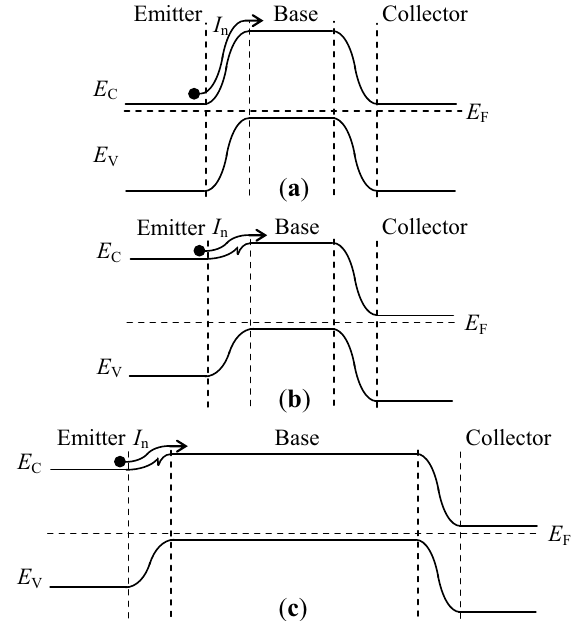
Figure 2. Transistor band diagrams: ( a ) Band diagram of the homojunction transistor; ( b ) Band diagram of the heterojunction transistor; ( c ) Band diagram of the HSMST with a long base